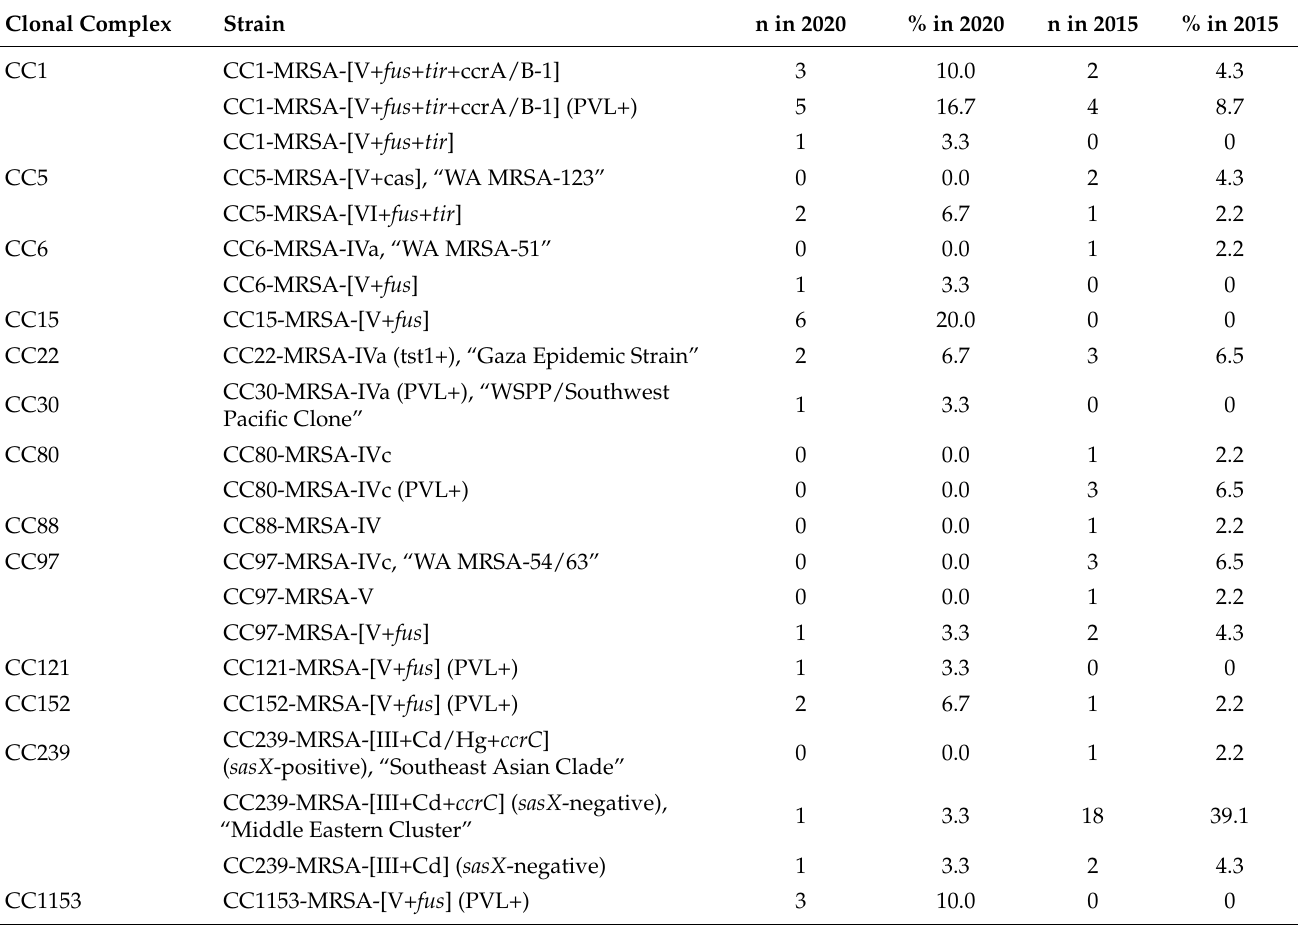
Table 5. Affiliations to CCs and strains, comparison to the data from the 2015 study [44]. Clonal Complex